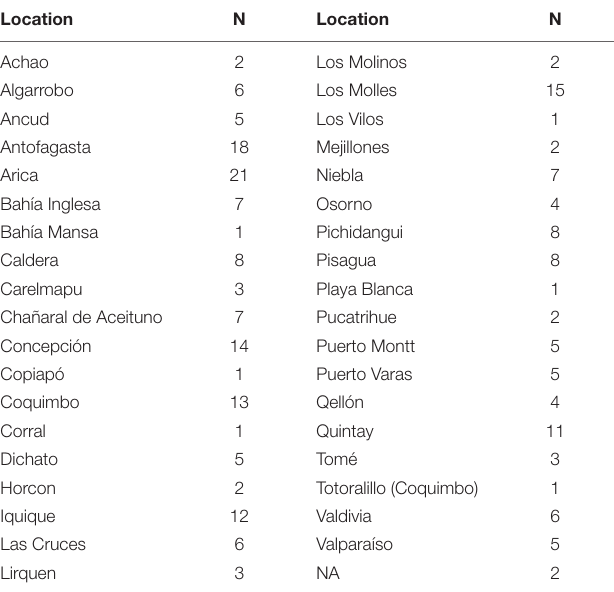
TABLE 1 | Number of divers surveyed in each